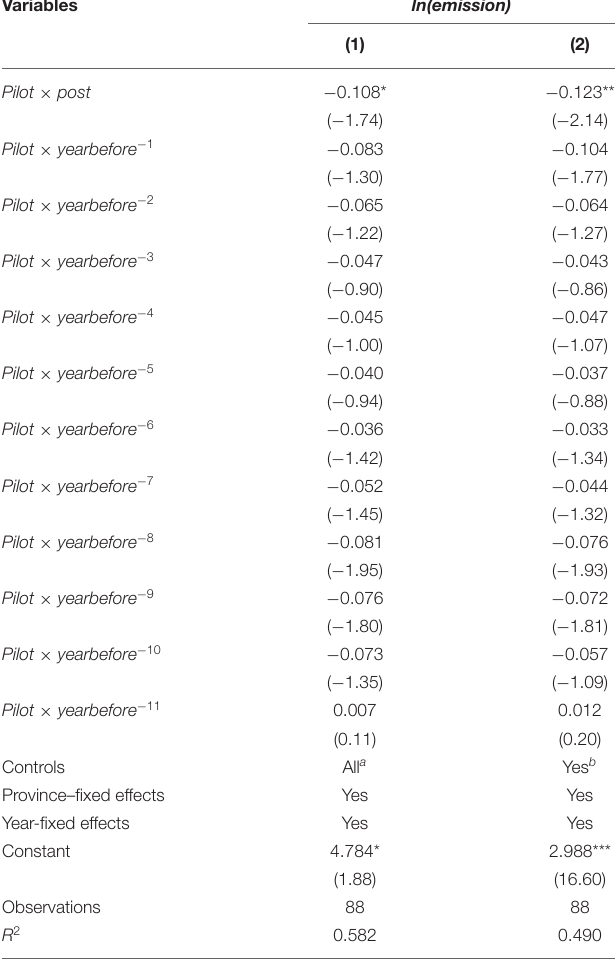
effect and consider the estimates of emission reduction effects by ETS as